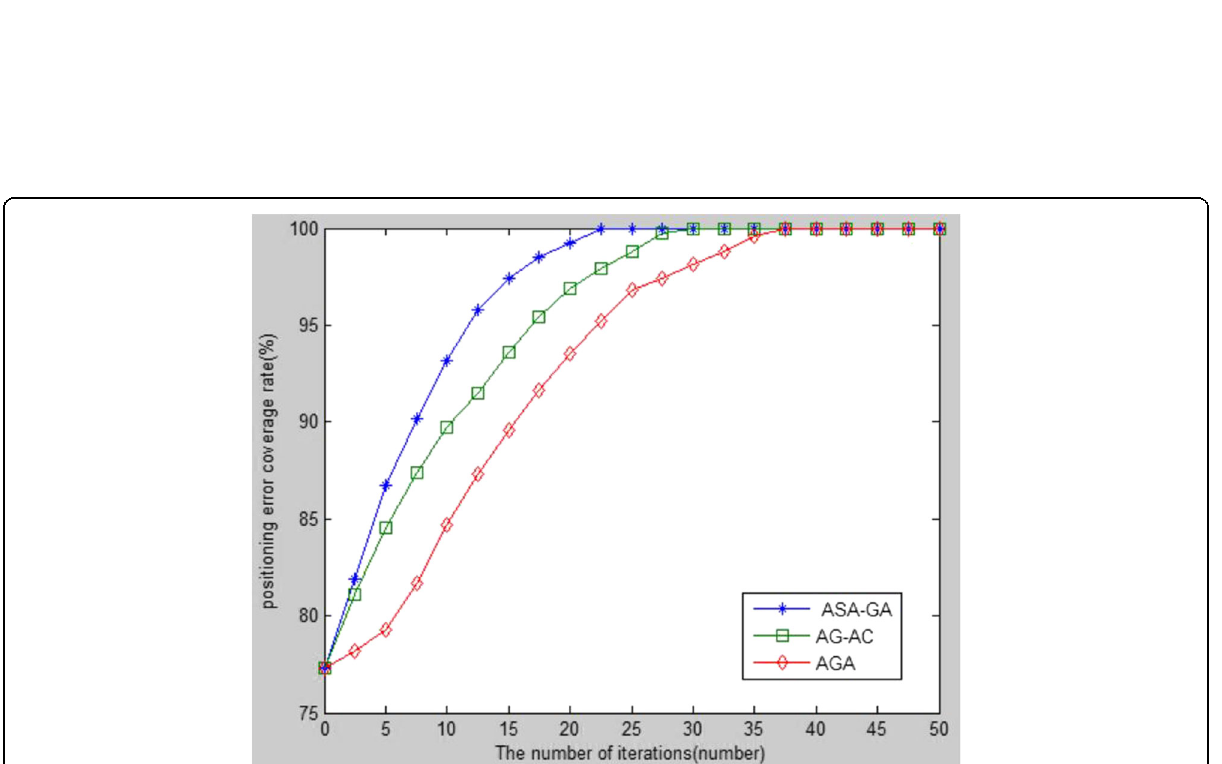
Fig. 6 Comparison of convergence of the three algorithms. The green curve with squares represents after AG-AC algorithm optimization, the curve with stars represents after ASA-GA algorithm optimization, and curve with diamonds represents after AGA algorithm optimization